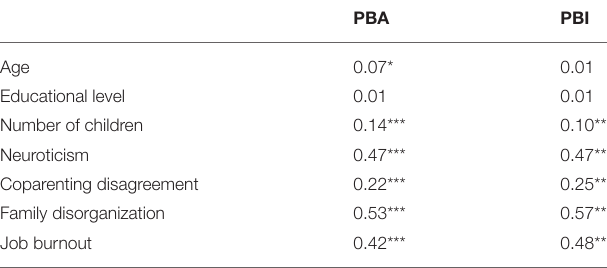
TABLE 5 | Correlations between the PBA, the PBI and other variables under